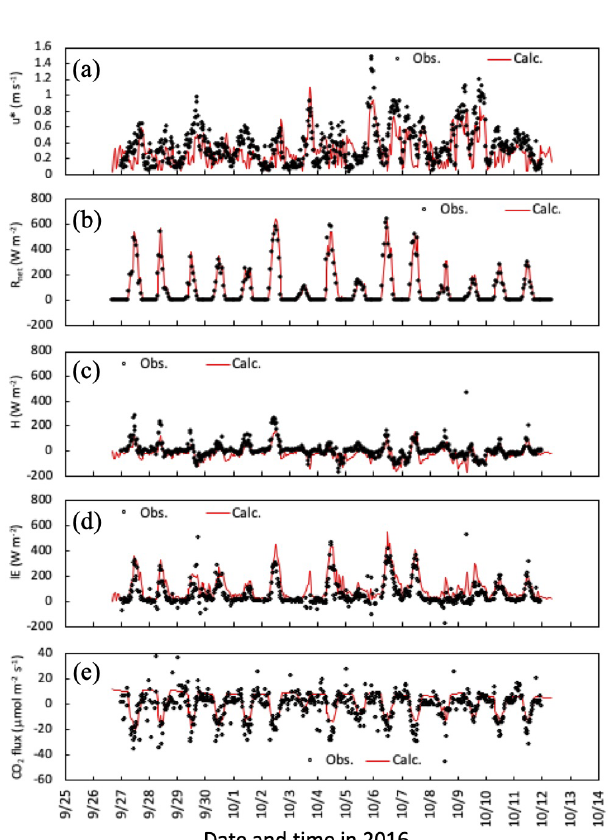
Figure 2. Temporal changes in observed and simulated (a) fric- tion velocity, (b) net radiation, (c) sensible and (d) latent heat, and (e) CO 2 fluxes from 27 September to 11 October 2016. Please note that the date is given on the x axis in the month/day format.